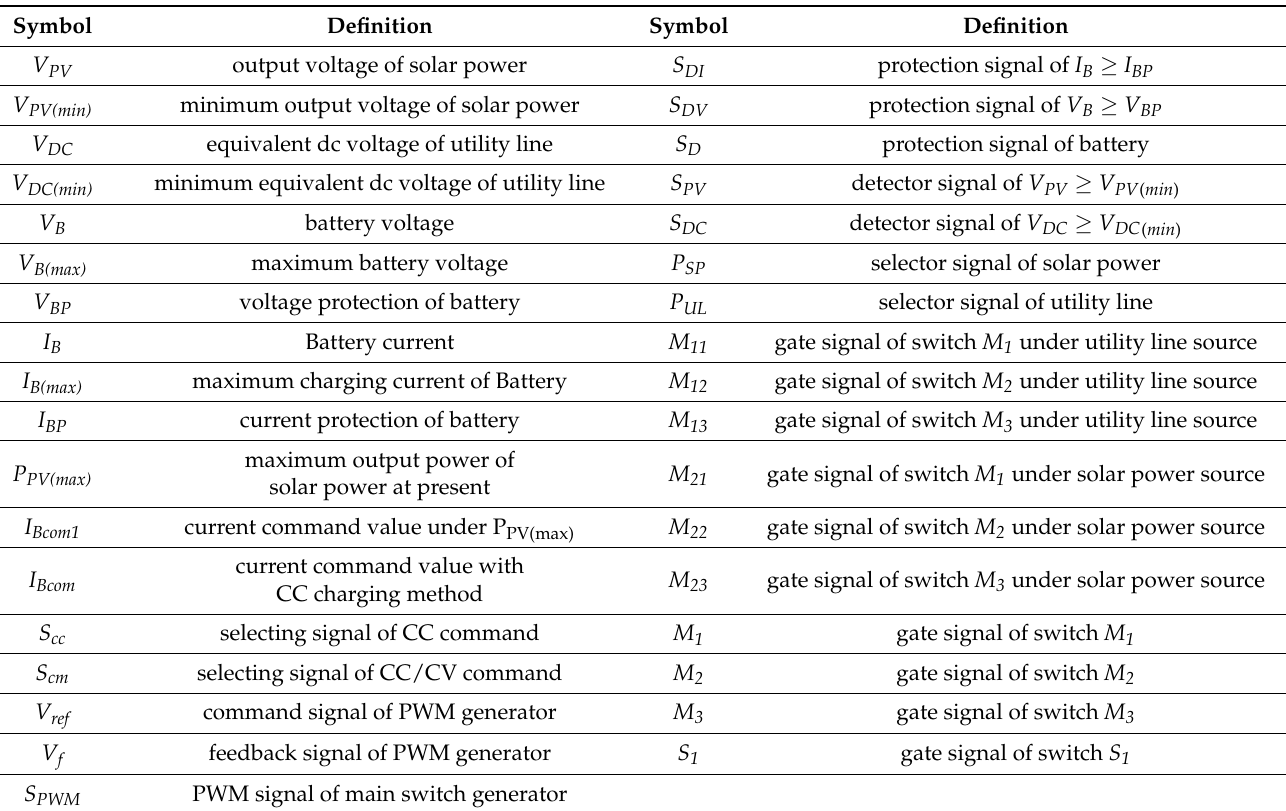
Table 2. Definitions of key parameters in Figure 13 for the controller of the proposed hybrid converter.